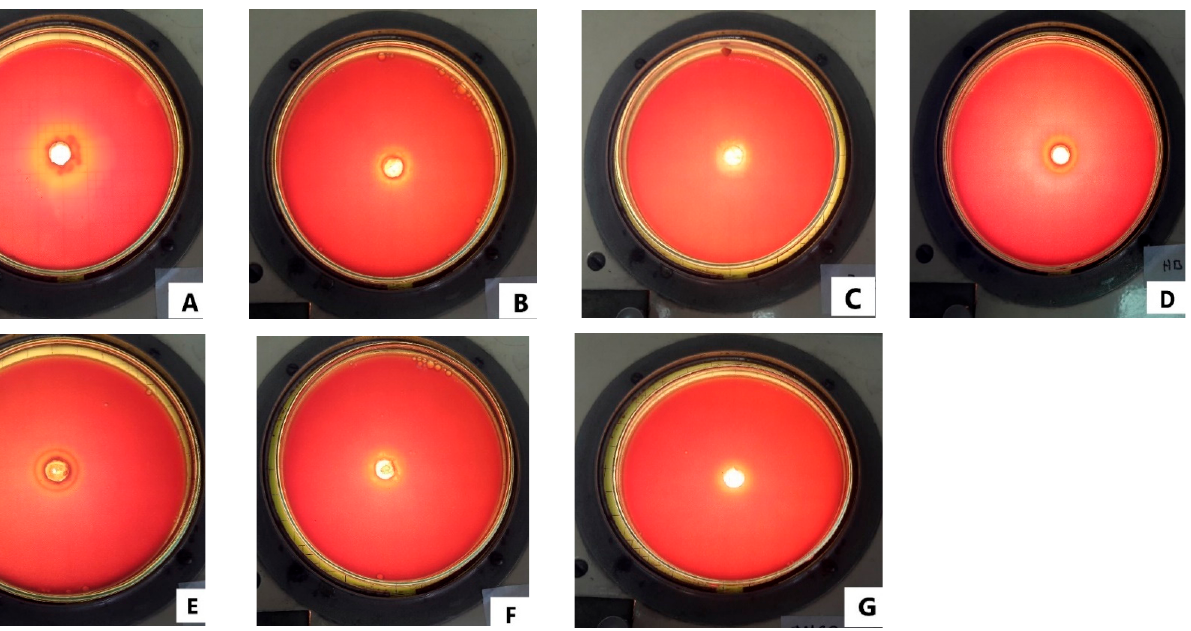
Figure 1. Agar-well diffusion method. ( A ) E. globulus EO 100% ( B ) E. globulus EO 50% ( C ) E. globulus EO 10% ( D ) M. spicata EO 100% ( E ) M. spicata EO 50% ( F ) M. spicata EO 10% ( G ) Solvent (DMSO 0.1%).